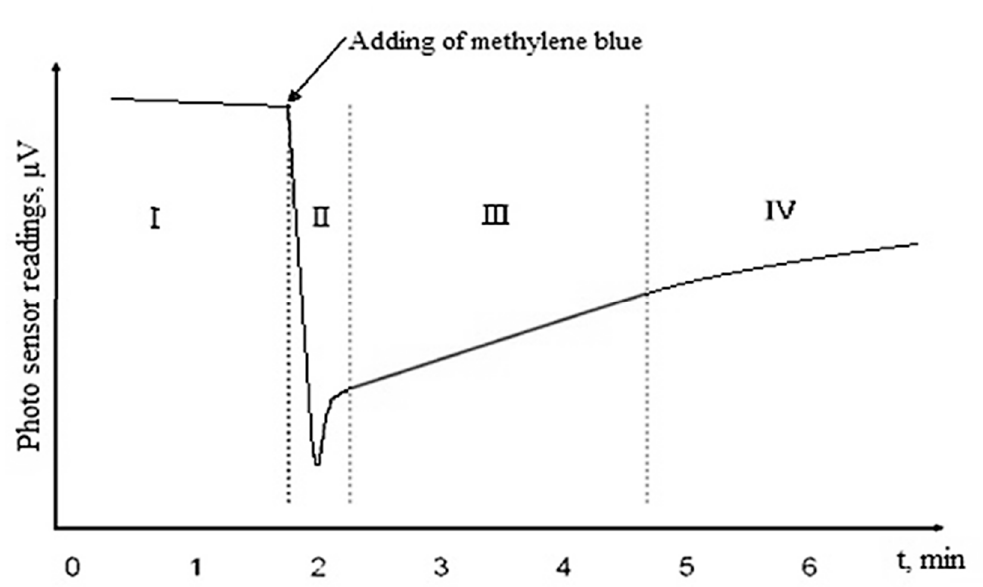
Figure 3. Kinetics of biological substrate oxidation by activated sludge in the presence of MB: (I) stabilization of the photosensor readings, (II) MB sorption on the biomass, (III) the linear region, (IV) the nonlinear region.